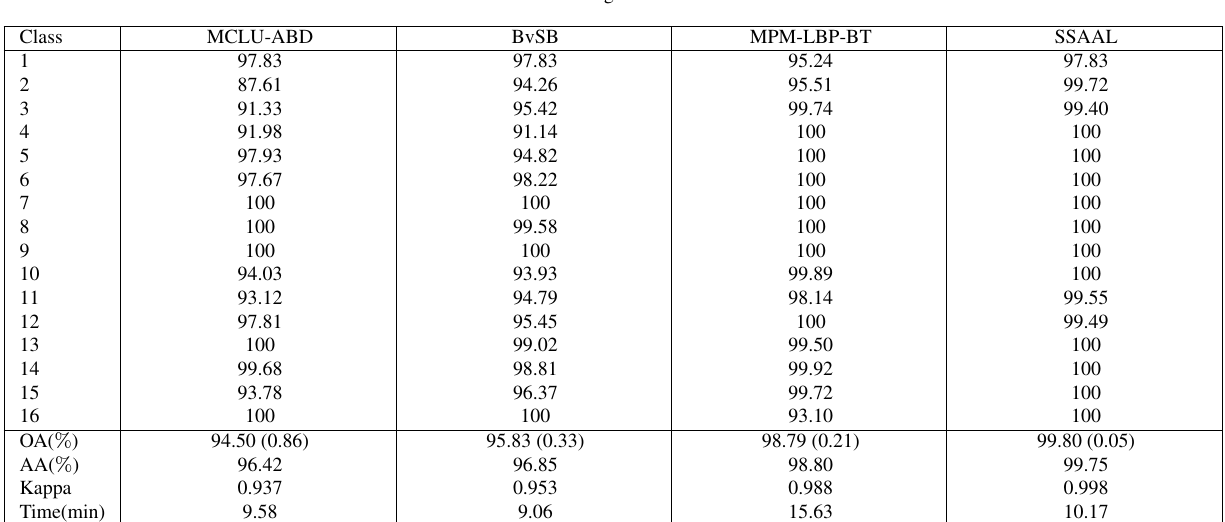
Table 5. Parameter settings for the three HSI datasets